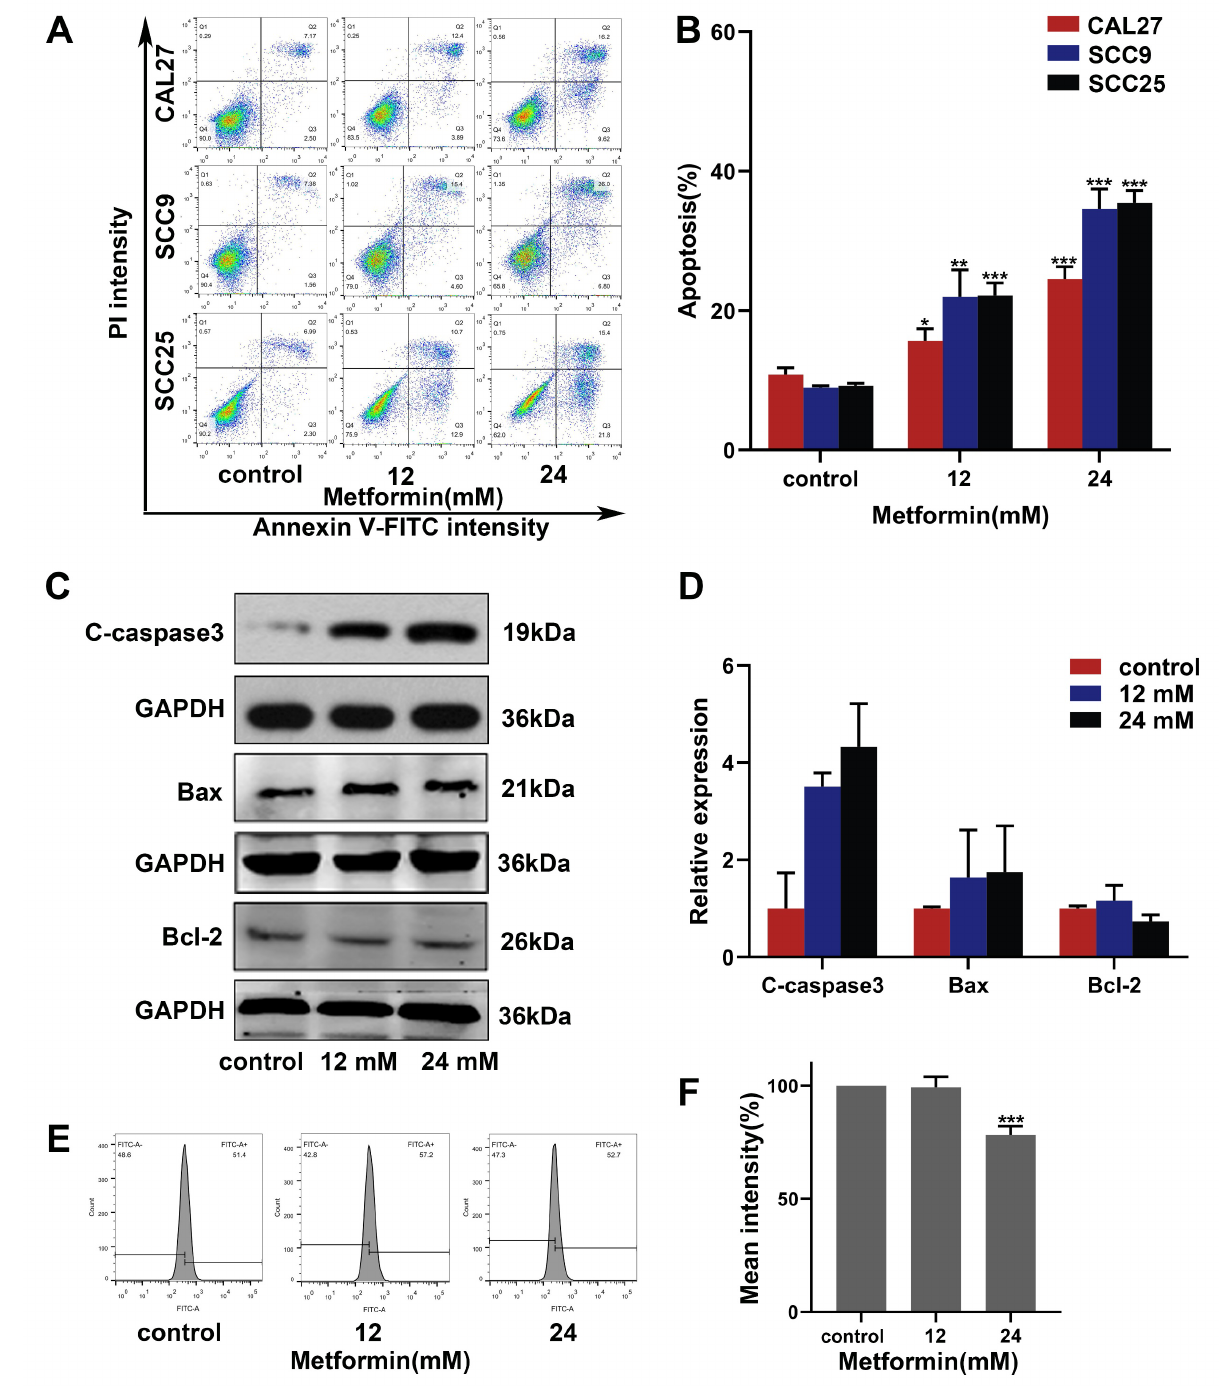
Figure 4. Metformin induced apoptosis in OSCC cells via a non-ROS dependent pathway. ( A , B ) The apoptosis assays were performed to assess the impact of metformin on apoptosis of OSCC cell lines (CAL27, SCC9, SCC25). The early apoptotic cells are located in the lower right quadrant, the late apoptotic cells are located in the upper right quadrant, and the necrotic cells are located in the upper left quadrant. ( C , D ) CAL27 cells were treated with different concentrations of metformin for 48 h, and then the apoptosis related proteins were analyzed by western blot. Original blots see Supplementary Figure S4. GAPDH was used as the internal reference protein. ( E , F ) Flow cytometry was used to measure intracellular ROS levels in CAL27 cells treated with various concentrations of metformin. The data are shown in the bar graph as mean ± SD, * p ≤ 0.05, ** p ≤ 0.01 and *** p ≤ 0.001 versus control